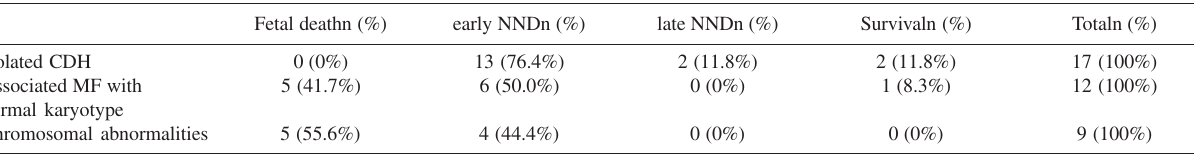
Table 2 - Perinatal outcome in cases with congenital diaphragmatic hernia according to associated structural and chromosomal